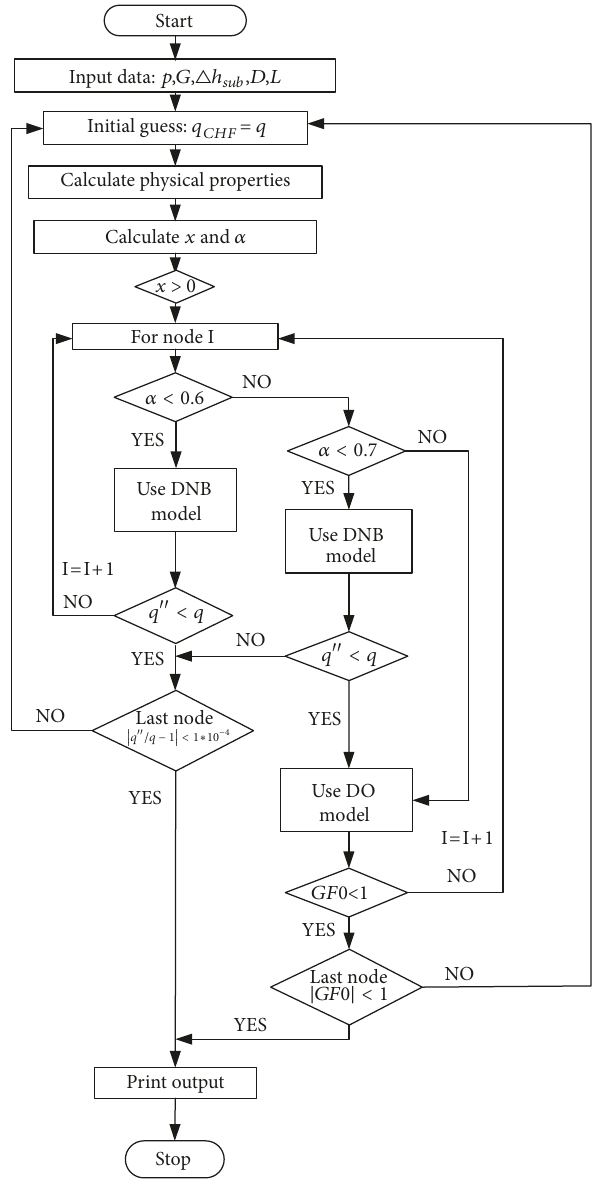
Figure 5: Flow chart of detailed